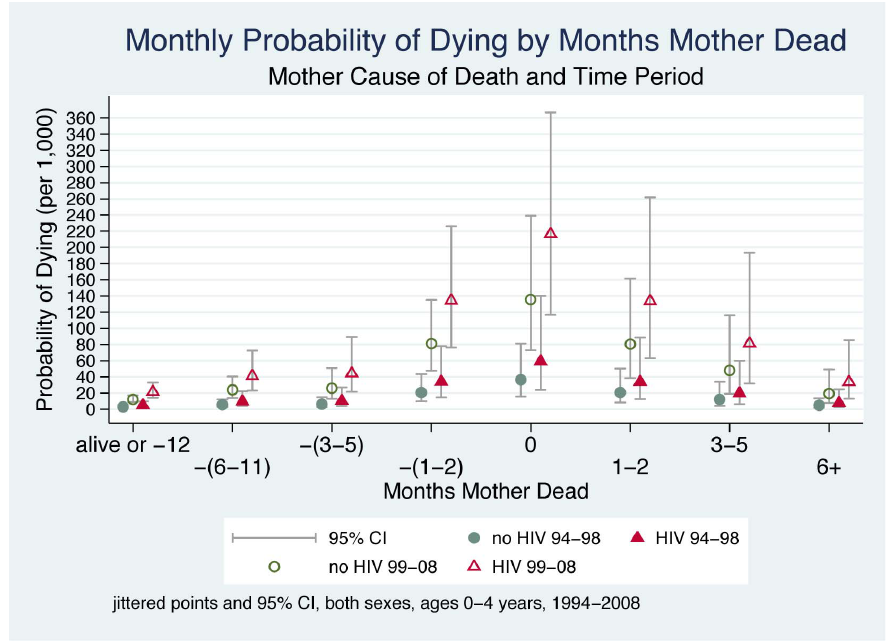
Figure 4. Monthly probability of child death in Agincourt sub-district, South Africa (1994–2008) by time before/after mother’s death, time period, and cause of mother’s death. The time periods (1994–1998 and 1999–2008) were selected to fall either side of a historical breakpoint separating the periods before and after HIV produced a major effect on mortality. On the x- axis, the mother’s death occurs in month 0, and time periods before and after her death are shown to the left and right of month 0, respectively. Children whose mother did not die during the study are included in the time period ‘‘alive or 2 12’’. Jittered (offset) points to reduce overplotting.